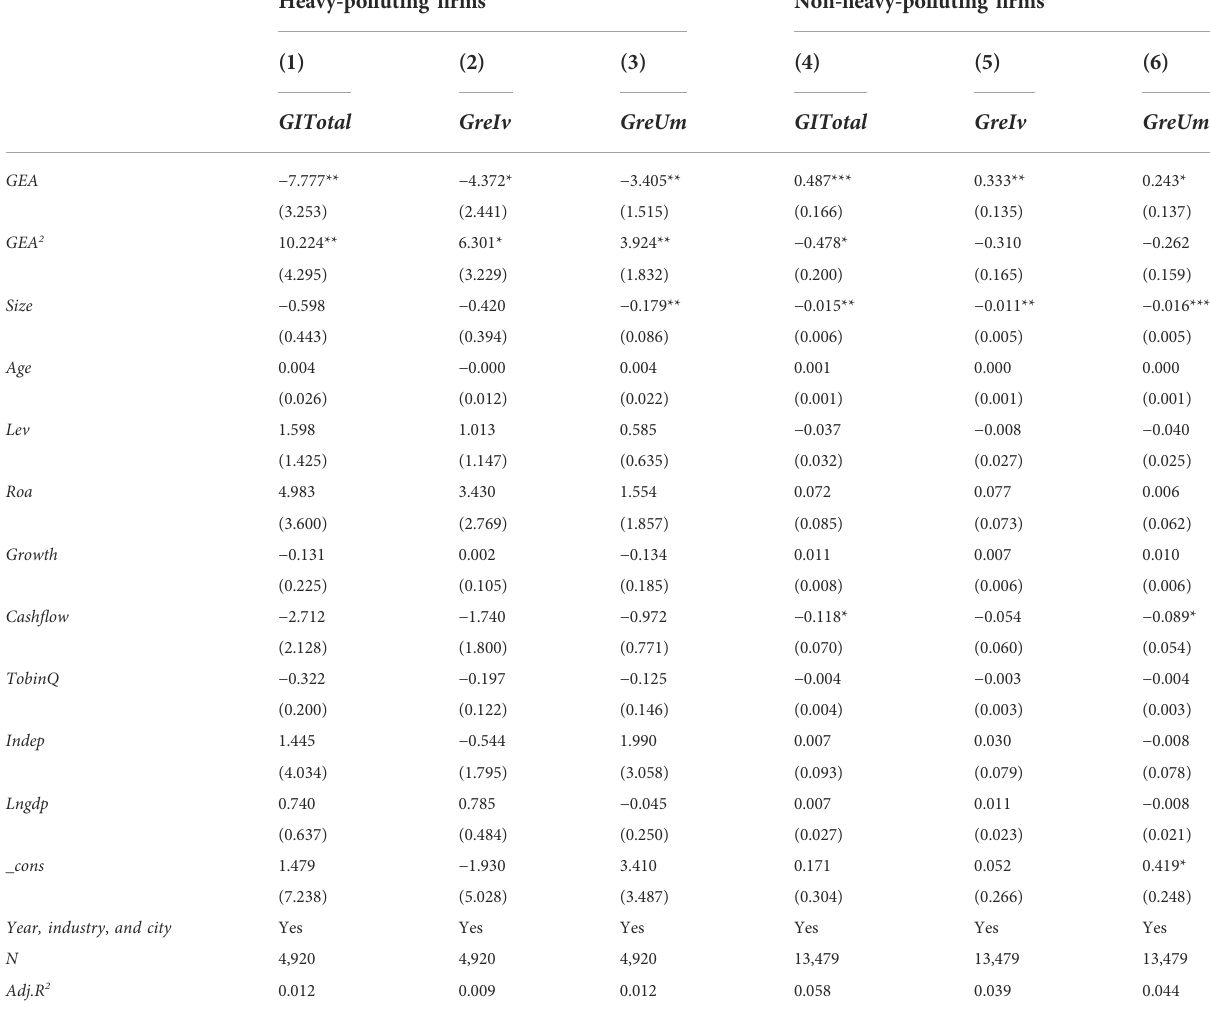
TABLE 2 Effect of government ’ s environmental attention on green